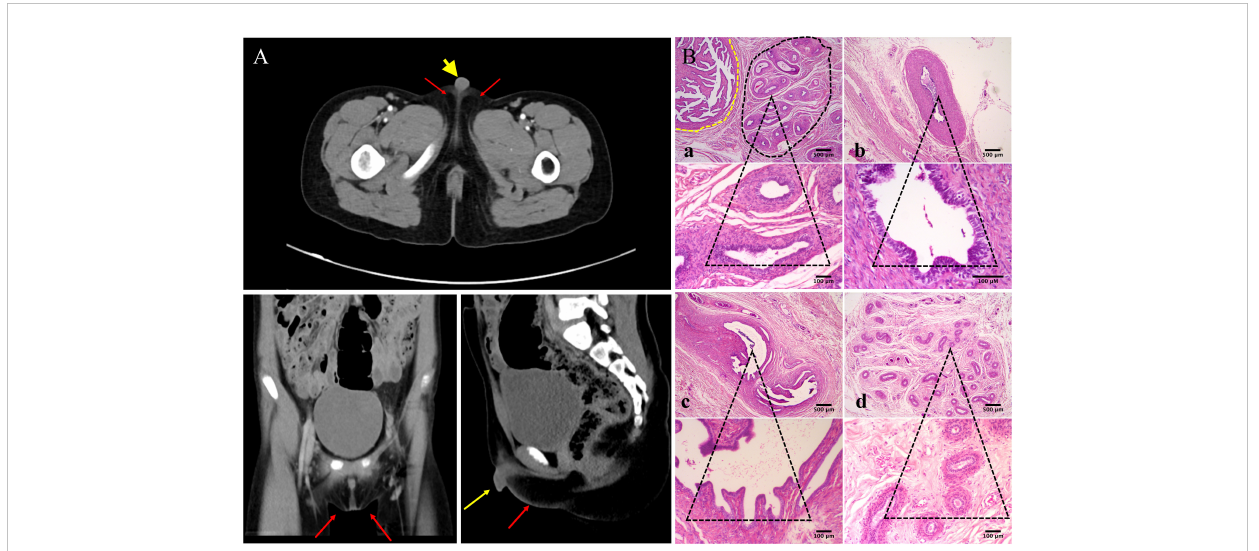
FIGURE 2 Urinary CT scan and post-surgical histopathology of the gonads of III:2. (A) CT scan of the urinary system shows empty scrotum (red arrows) and small penis (yellow arrow). (B) Histologic analysis of gonad samples from III:2. No gonadal tissue was observed; however, fallopian tube-like and epididymal-like structures were present in both gonads of the patient. (a) Fallopian tube-like (circled by yellow dashed line) and epididymal-like structures (circled by black dashed line) on the left side were seen in the same microscopic fi eld; (b) remnants of the ductus deferens were also present on the sample from the left side; (c) fallopian tube-like and (d) epididymis-like structures on the right side. The lower panel shows indicated tissues on the upper panel at higher magni fi cation. Size bars are indicated for each panel. Staining was performed with hematoxylin – eosin.